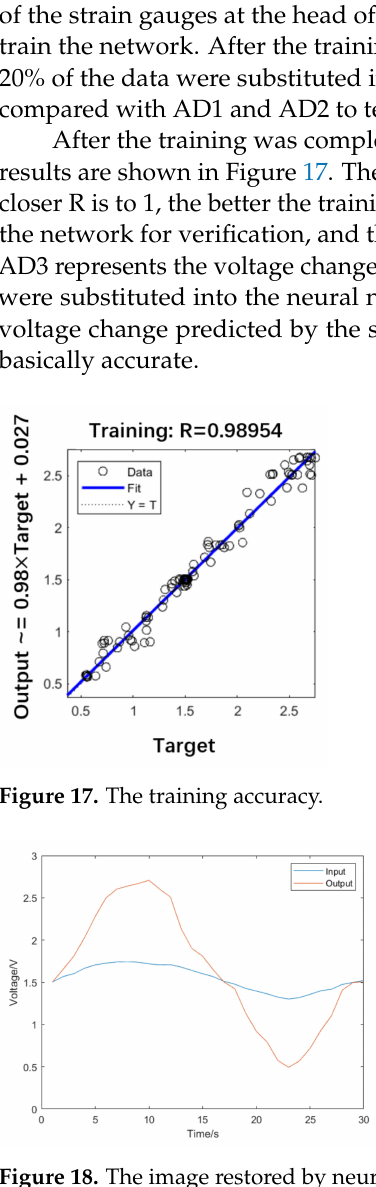
Figure 18. The image restored by neural